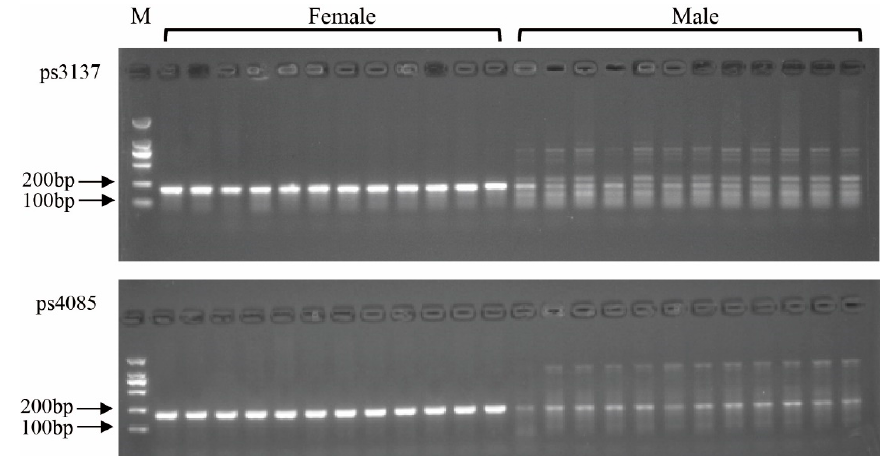
Figure 2. Detection marker ps4085 and ps3137 in male and female Pelodiscus sinensis populations.